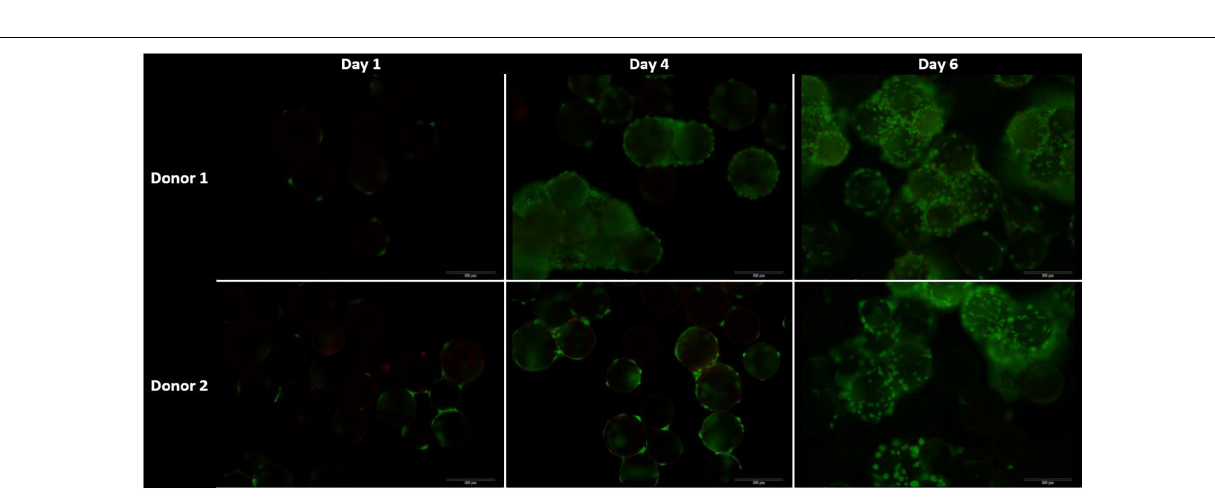
Frontiers in Bioengineering and Biotechnology |